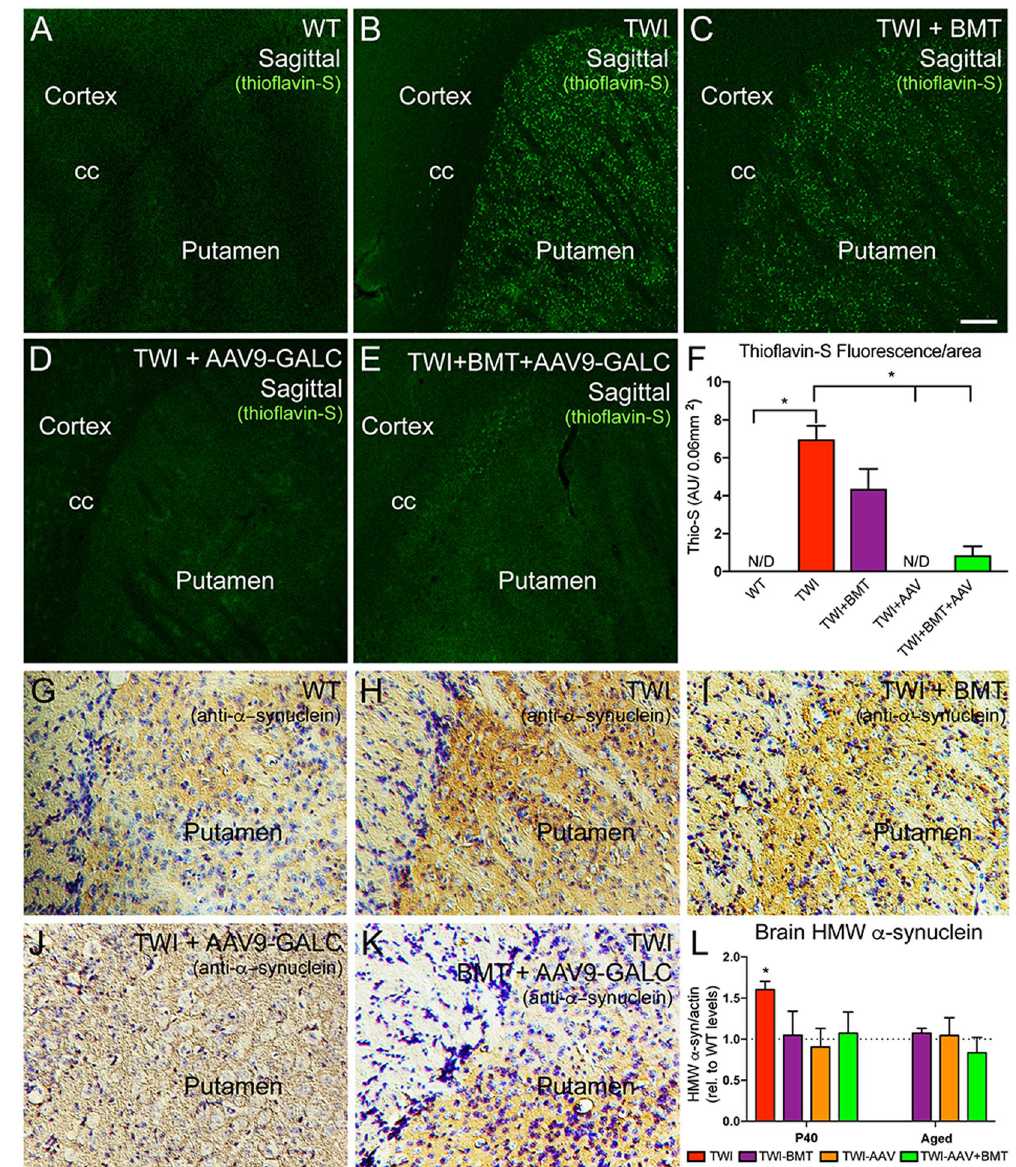
Figure 2. Neuronal thioflavin-S aggregates and high-molecular-weight α -synuclein aggregates are greatly reduced upon AAV9-GALC gene therapy. Thio-S + protein aggregates in TWI ( B ), previously shown to be intra-neuronal and partly comprised of α -synuclein 1 , were eliminated at P40 after neonatal gene therapy using AAV9-GALC vectors alone 31 ( D ) or in combination with bone marrow transplantation (BMT + AAV9- GALC) ( E ), but not by BMT alone ( C ). WT comparison in ( A ). Images show anatomical regions encompassing deep cerebral cortex and the putamen. cc, corpus callosum. Thio-S + aggregates (fluorescent units per area) remained largely eliminated in AAV9-GALC and BMT + AAV9-GALC brains ( F ). * p < 0.05, compared to WT, ANOVA; n = 3–4 mice per group). ( G , K ) Gene therapy with AAV9-GALC greatly normalized α -synuclein levels in the cortex/putamen region (compare J and K with H ). Sections were stained with diamino-bencidine for α -synuclein and counterstained with toluidine blue. ( L ) Total brain lysates from young (P40) and long- surviving ( > P200) TWI, AAV9-GALC treated TWI and control mice 31 were immunoblotted for α -synuclein, and high-molecular-weight bands (~30 to ~100 kDa) were quantified by optical densitometry. Results are expressed as fold levels over basal levels in WT brains. * p < 0.05, ANOVA; n = 3–4 mice per group. Scale bar: 200 μ